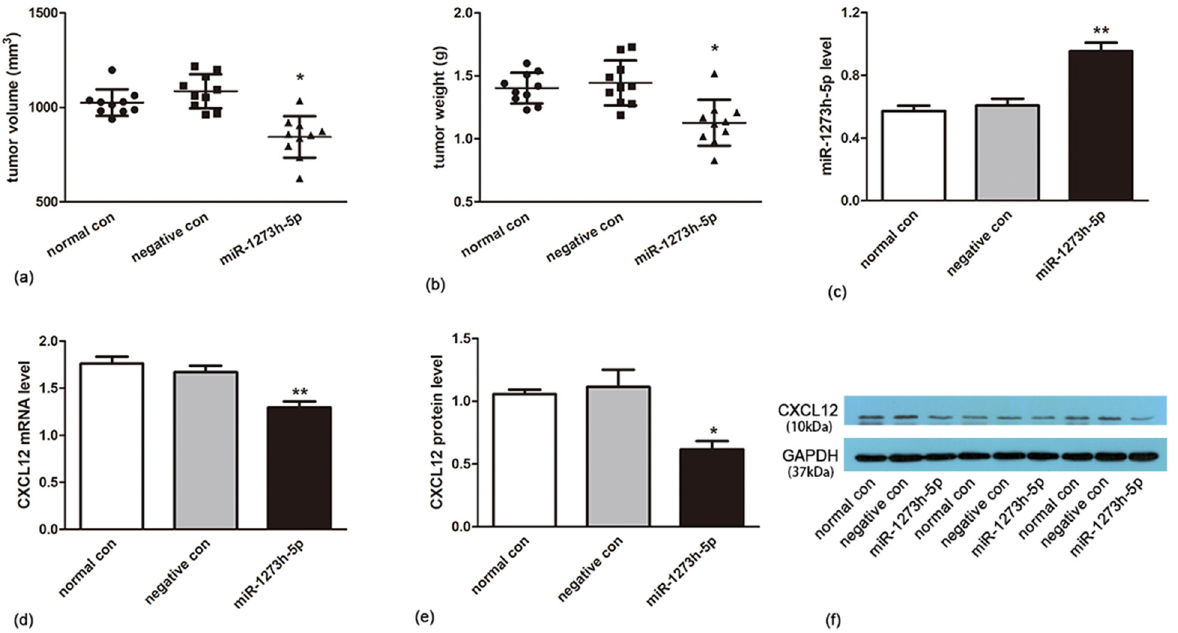
Figure 8: E ff ect of miR - 1273h - 5p on SGC - 7901 cell transplanted mice model. ( a and b ) Tumor volume and weight of cancer tissue among the normal control group, negative control group, and miR - 1273h - 5p group revealed signi fi cant reductions. ( c and d ) The expression of miR - 1273h - 5p and CXCL12 at the mRNA level in normal control, negative control, and the miR - 1273h - 5p transfected groups was evaluated using RT - PCR. In contrast with the negative group, the miR - 1273h - 5p group signi fi cantly increased. ( e and f ) The expression of CXCL12 at the protein level in three groups was determined by Western blotting analysis. The miR - 1273h - 5p group signi fi cantly decreased compared to the negative group. All data were represented as M ± SD from three independent experiments compared with the negative control group, * P < 0.05, ** P <